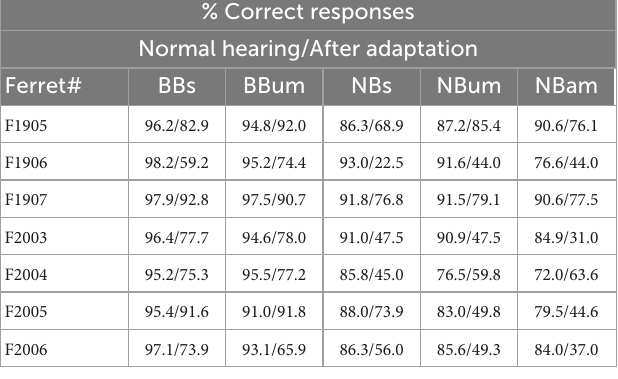
TABLE 5 Sound localization accuracy for different